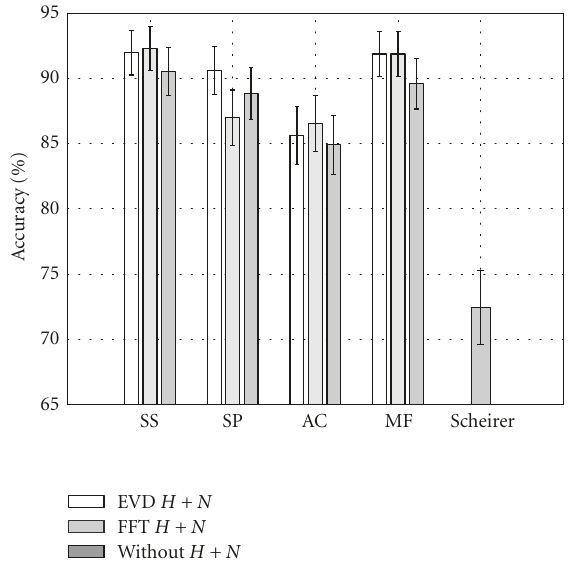
Figure 14: Algorithm comparison to see the influence of the H + N decomposition. The error bar indicates the 95% confidence interval calculated as 1 . 96